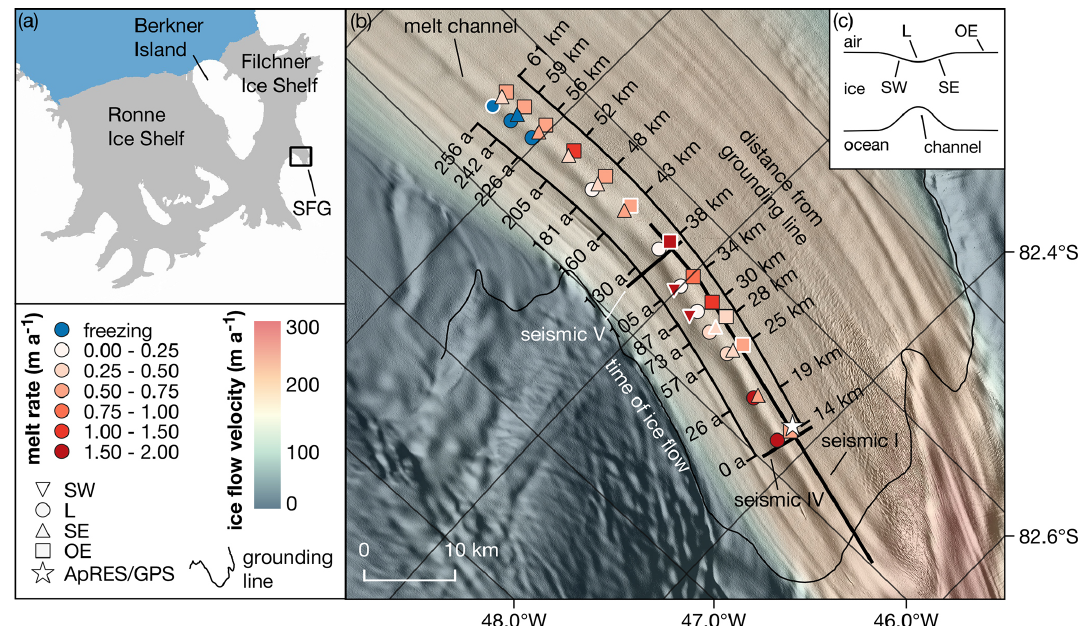
Figure 1. (a) Map of the Ronne and Filchner ice shelves. The study area near the Support Force Glacier (SFG) is marked with a black box. (b) Study area with pRES-derived basal melt rates at 13 cross-sections of the melt channel. The different symbols indicate the position relative to the channel, as shown in panel (c) . Those melt rates derived from a nadir and an off-nadir basal return are marked with a white outline. For each cross-section, the distance from the grounding line and the duration of ice flow from the location furthest upstream are given. The location of an ApRES/GPS station is shown by a star. The seismic I, IV and V lines mark the location of active seismic profiles (Hofstede et al., 2021a, b). The background is a hillshade of the Reference Elevation Model of Antarctica (Howat et al., 2018, 2019) overlaid by the ice flow velocity (Hofstede et al., 2021a). (c) Sketch of a cross-section of the channel with measurement locations on the steepest western surface flank (SW), at the lowest surface elevation (L), on the steepest eastern surface flank (SE) and outside the east of the channel